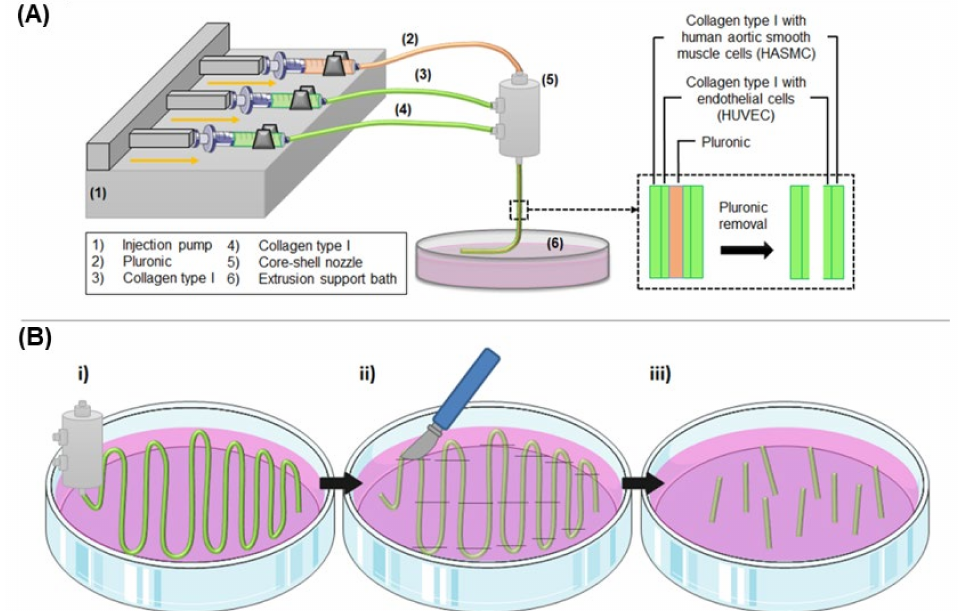
Figure 4. Schematic representation of collagen TEBV development through the triple concentric extrusion method. ( A ) Pluronic (2) and collagen type I (3 and 4) are injected into a triple concentric nozzle (5) in the inner, middle and outer layer, respectively. These biomaterials are extruded in a constant injection speed controlled by an injection pump (1) into a petri dish containing an extrusion support bath or support-free bath (6). Independently of the extrusion support bath, the fibers are extruded at room temperature (approximately 20 ◦ C) for around 5–10 min, followed by incubation at 37 ◦ C for 10–15 min to allow collagen gelation. Then, Pluronic is removed from the inner core by dissolution with cell culture media, obtaining a hollowed dual layer tubular structure. ( B ) (i) Co-axial nozzle extrudes following a zig-zag pattern, and once TEBVs are gelled (ii–iii) the straight parts are cut to the desired